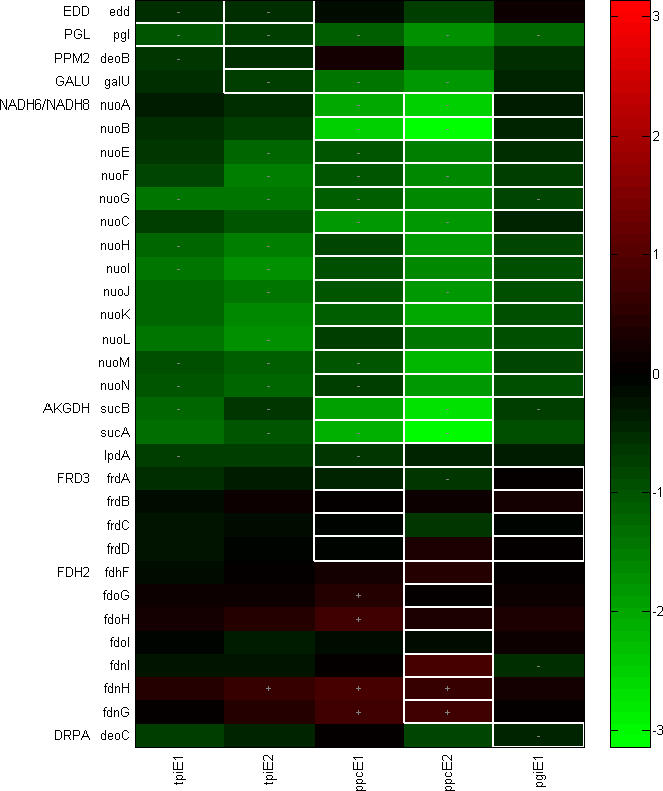
Correspondence between Bottleneck Reactions Identified by the OMNI Approach and Gene Expression Changes in the Evolved Knockout Strains Relative to the Wild-Type E. coli StrainExpression changes, reported as log2 ratios and statistically significant expression changes (see Materials and Methods for details) in each evolved strain, are shown by +/− signs depending on the direction of the change. The reaction names are listed in the first column and the corresponding genes are listed in the second column. The genes corresponding to the best combination of reaction bottlenecks of up to three reactions identified by the OMNI approach (Table 3) for each strain are shown by white boxes.